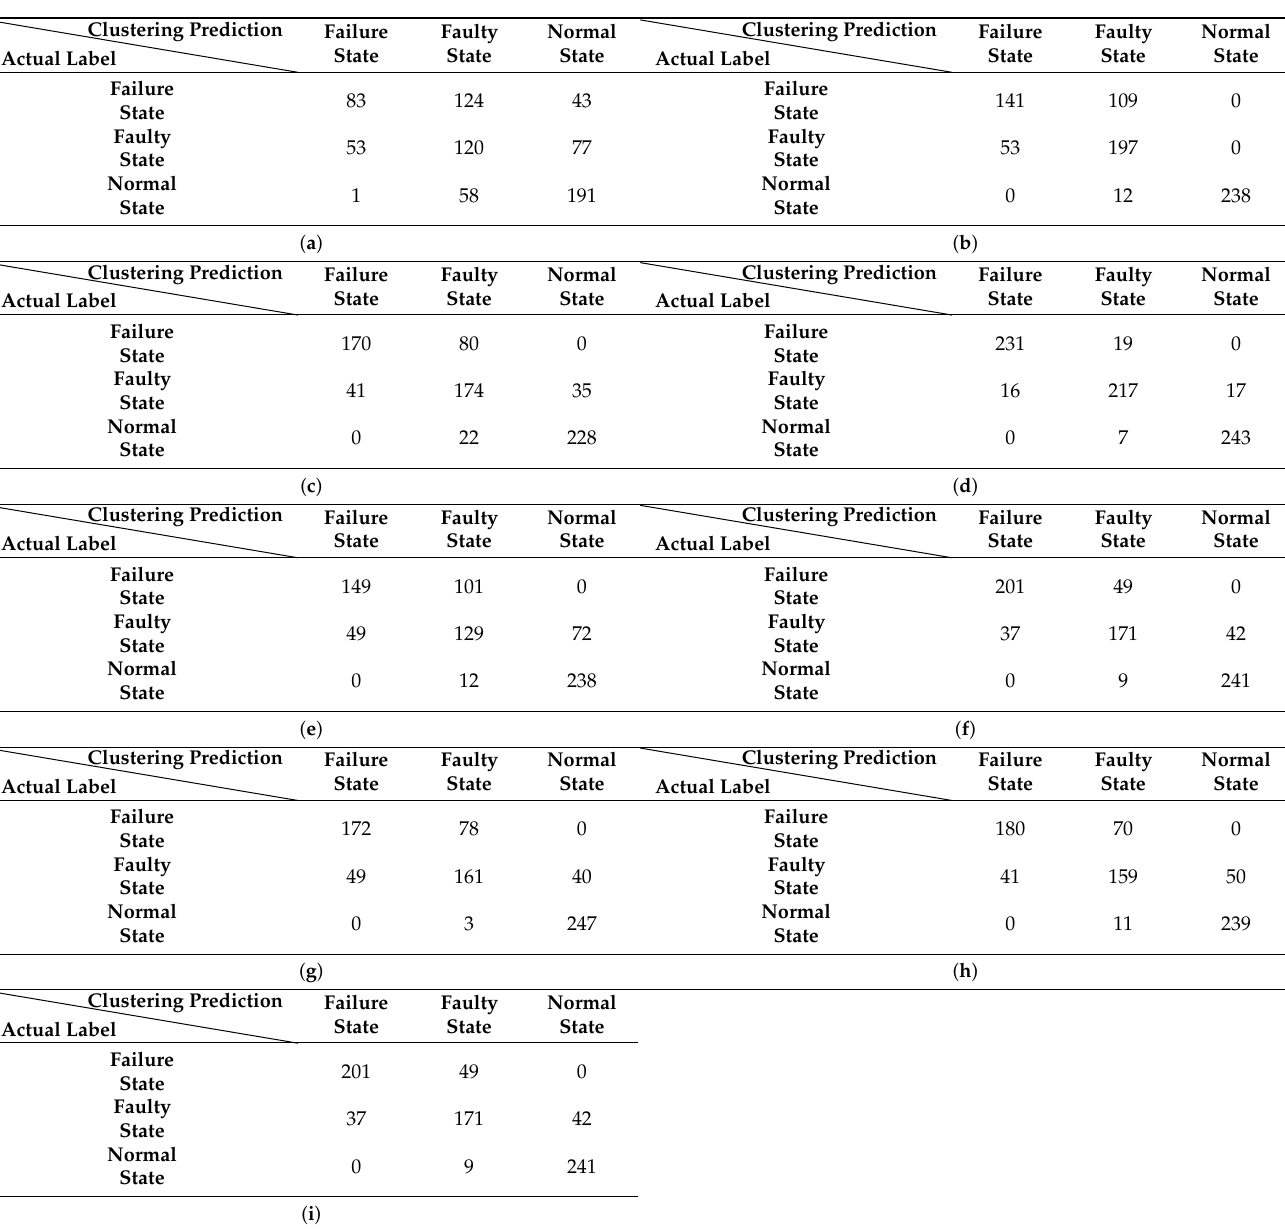
Table 4. Confusion Matrices for ( a ) aY, ( b ) aZ, ( c ) gY-aY, ( d ) gZ-aZ, ( e ) gX-gZ-aX, ( f )